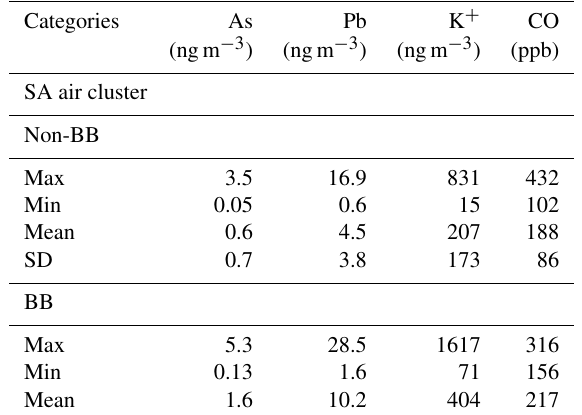
Table 2. The max, min, mean, and standard deviation values of As, Pb, K + , and CO concentrations on the BB and Non-BB days in SA and SEA air clusters during the S and SE Asian BB periods (from January to